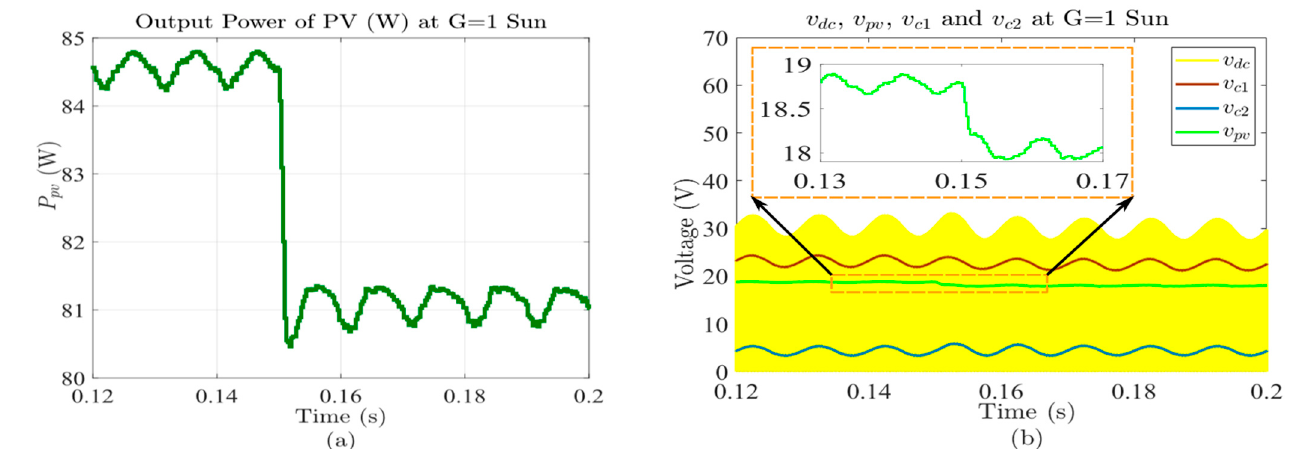
Figure 8. The waveforms of ( a ) P pv and ( b ) v pv , v dc , v c 1 , and v c 2 under changing temperatures.